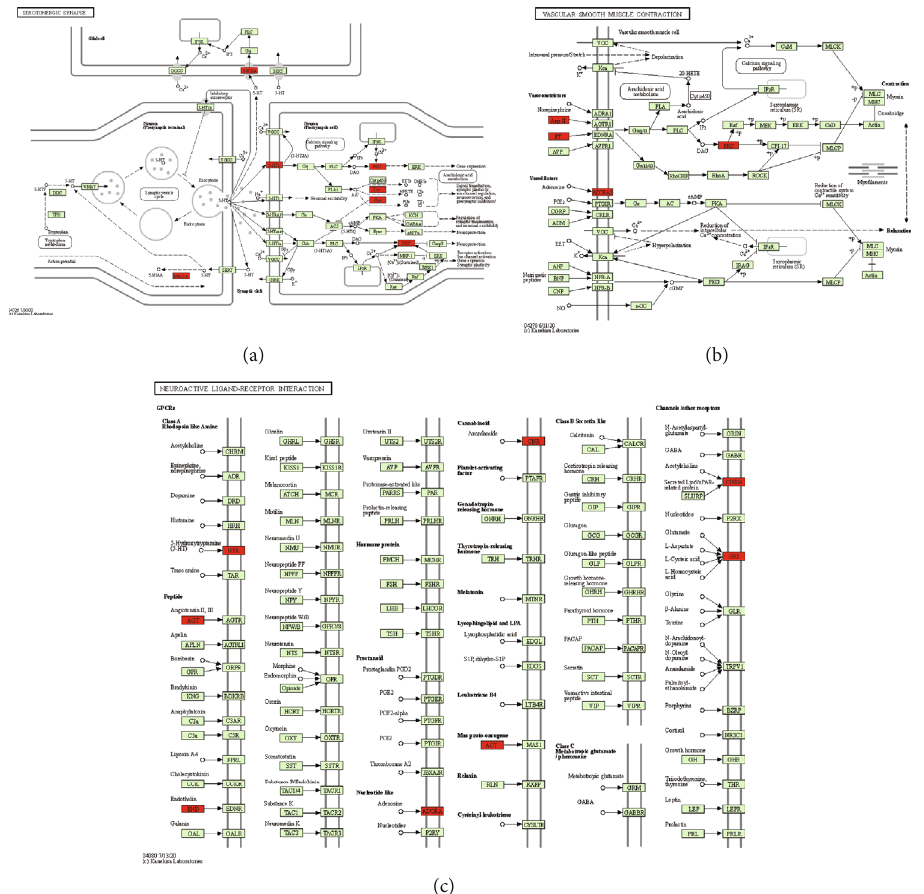
Figure 5: (a) hsa04726: serotonergic synapse pathway. (b) hsa04270: vascular smooth muscle contraction pathway. (c) hsa04080: neuroactive ligand – receptor interaction pathway. Red represents the critical genes involved in the